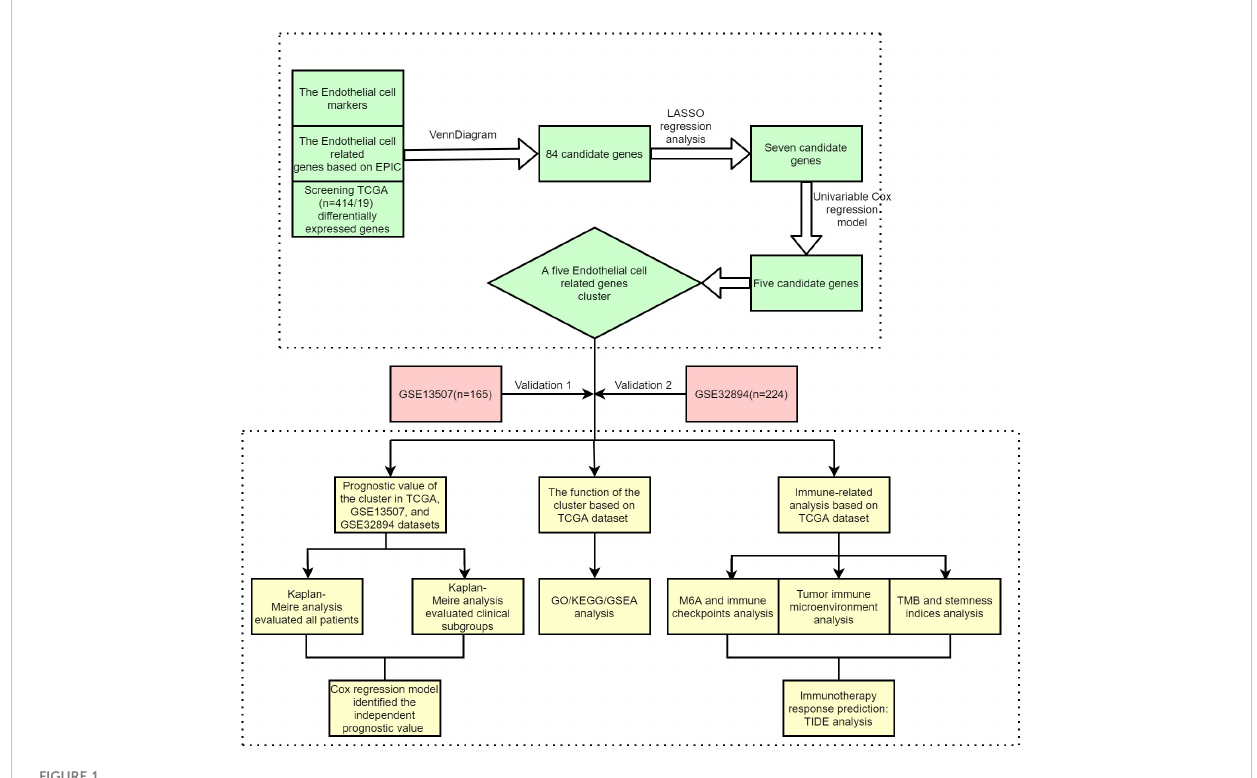
FIGURE 1 The work fl ow of this